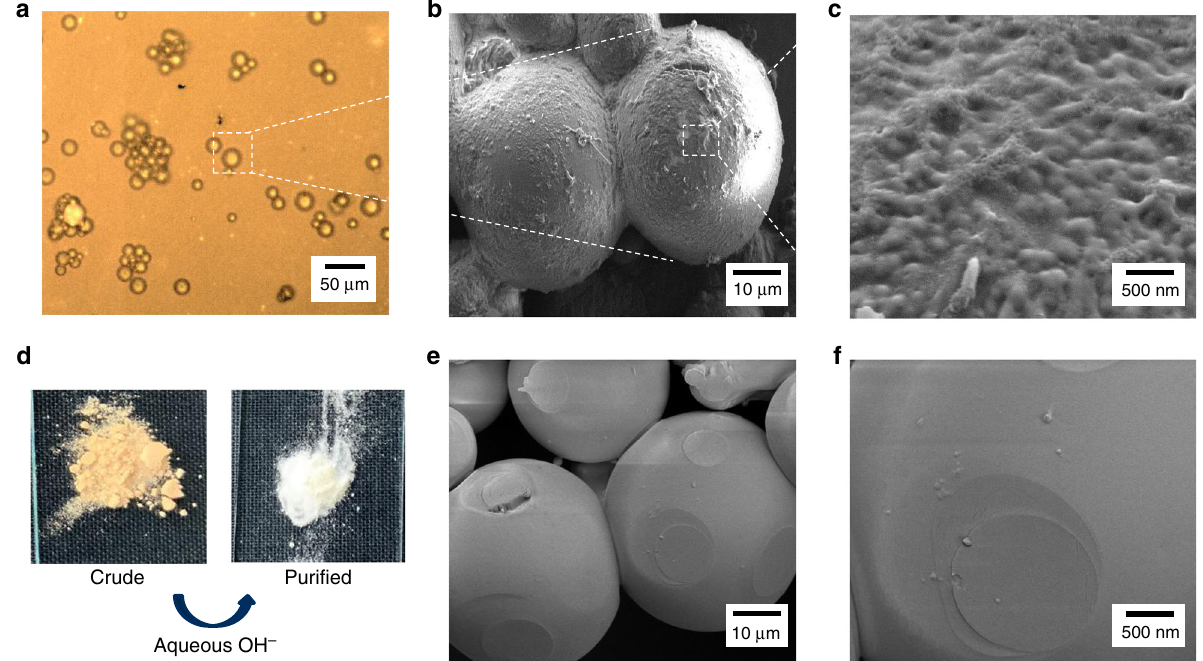
Fig. 5 Characterization of PBMA-GOx-chi-LNPs latex dispersions. a Optical microscopic and b , c SEM images of the lignin-coated PBMA microbeads after SET-LRP process. d Digital images of PBMA before and after the puri fi cation step using basic aqueous solution (NaOH, 0.1 M). e , f SEM images